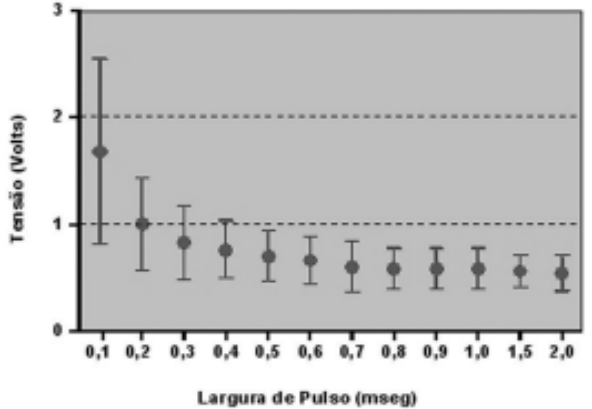
Fig. 2 - Curva de tensão x largura de pulso (média ± DP) do novo eletrodo para o limiar agudo de estimulação do miocárdio fetal. n = 5, valores = média ± desvio padrão